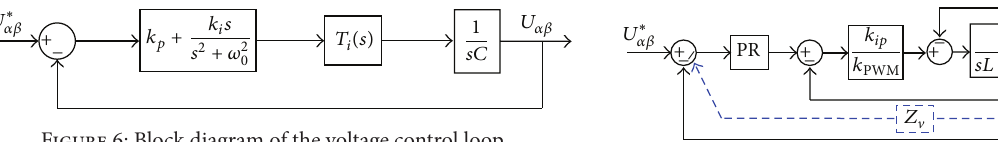
Figure 8: Bode diagram of voltage/current control